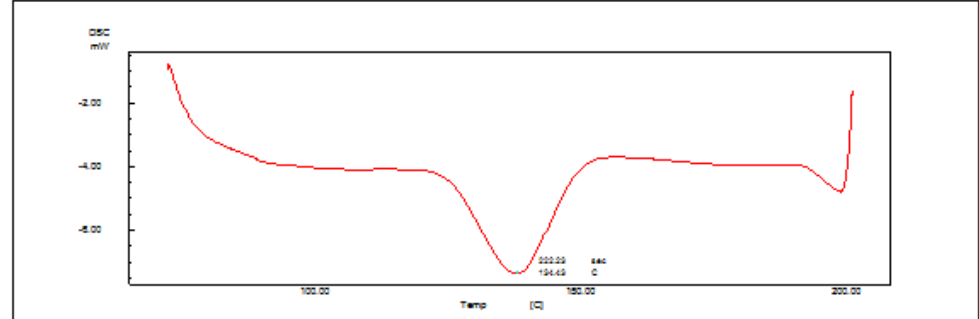
Figure 1. DSC thermograms of pure tacrolimus